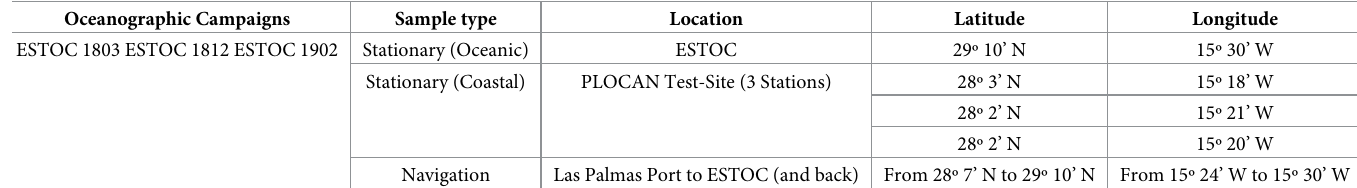
Table 1. Coordinates of the sampling